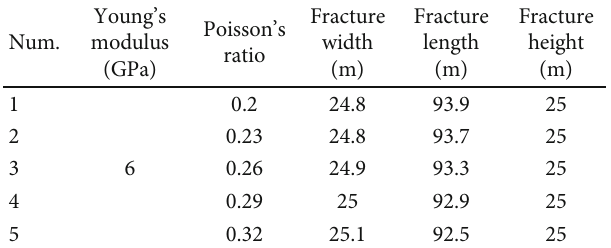
Table 3: Fracture extension scales under di ff erent Poisson ’ s